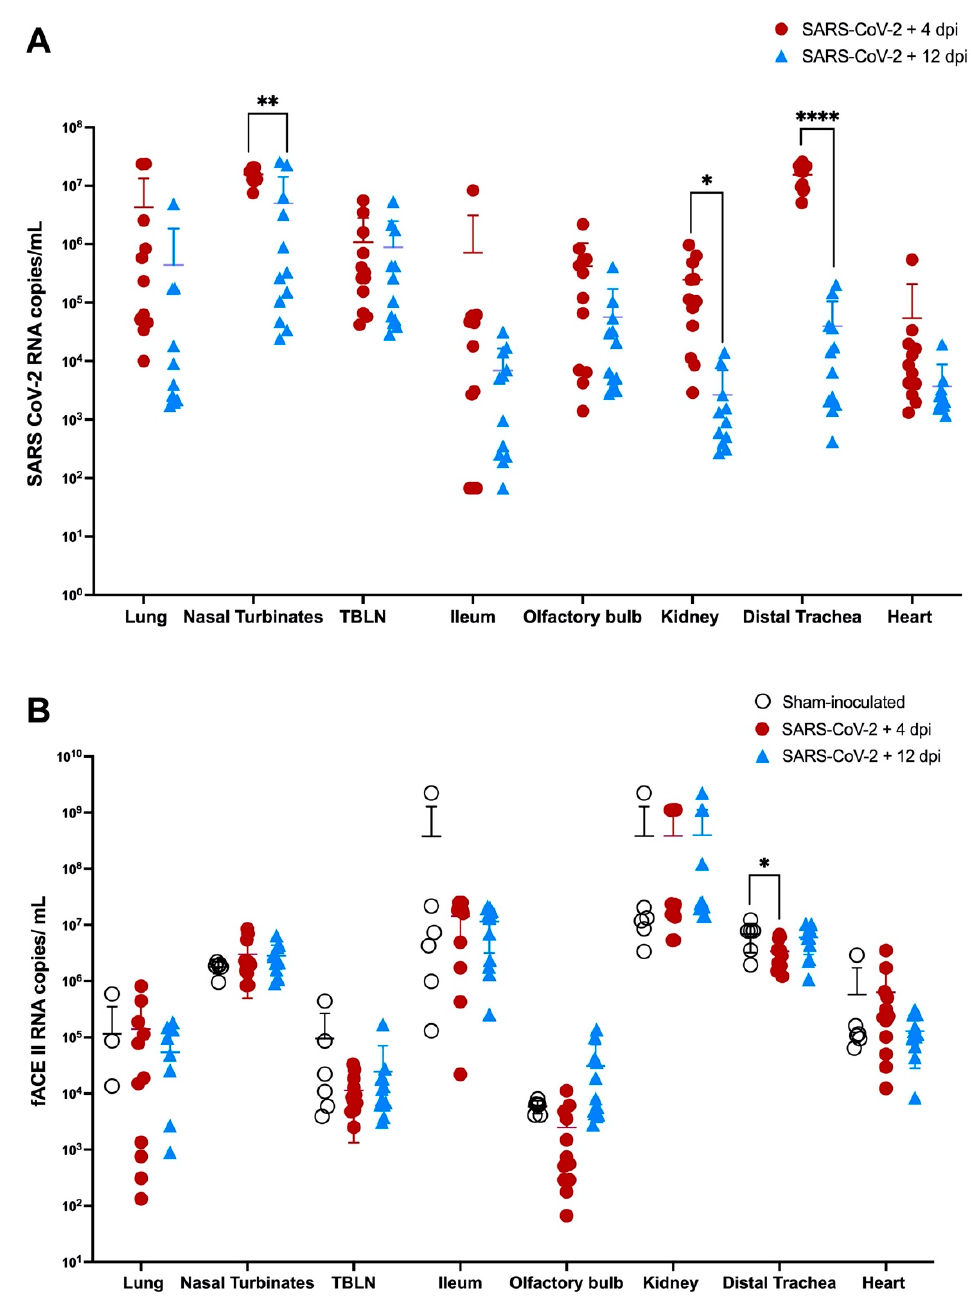
Figure 6. SARS CoV-2 viral RNA and f-ACE2 RNA quantification in infected feline tissues. ( A ) SARS CoV-2 viral copies are quantified from all the tissues collected at 4 and 12 dpi from SARS CoV-2 infected cats. Viral loads in the distal trachea, kidney, and nasal turbinates were significantly higher at 4 dpi compared to 12 dpi during the SARS-CoV-2 Delta variant. Viral RNA copies were also slightly increased in the olfactory bulb at 4 dpi compared to 12 dpi ( p = 0.08) ( B ) f ACE2 receptor RNA is significantly decreased in the distal trachea compared to sham-inoculated controls ( p = 0.0456). Data are expressed as means ± SD ( n = 12) cats per group. Tissues from sham-inoculated cats had no detectable virus. Statistical comparisons are made via one-way ANOVA. * p < 0.05, ** p < 0.01, **** p < 0.0001.